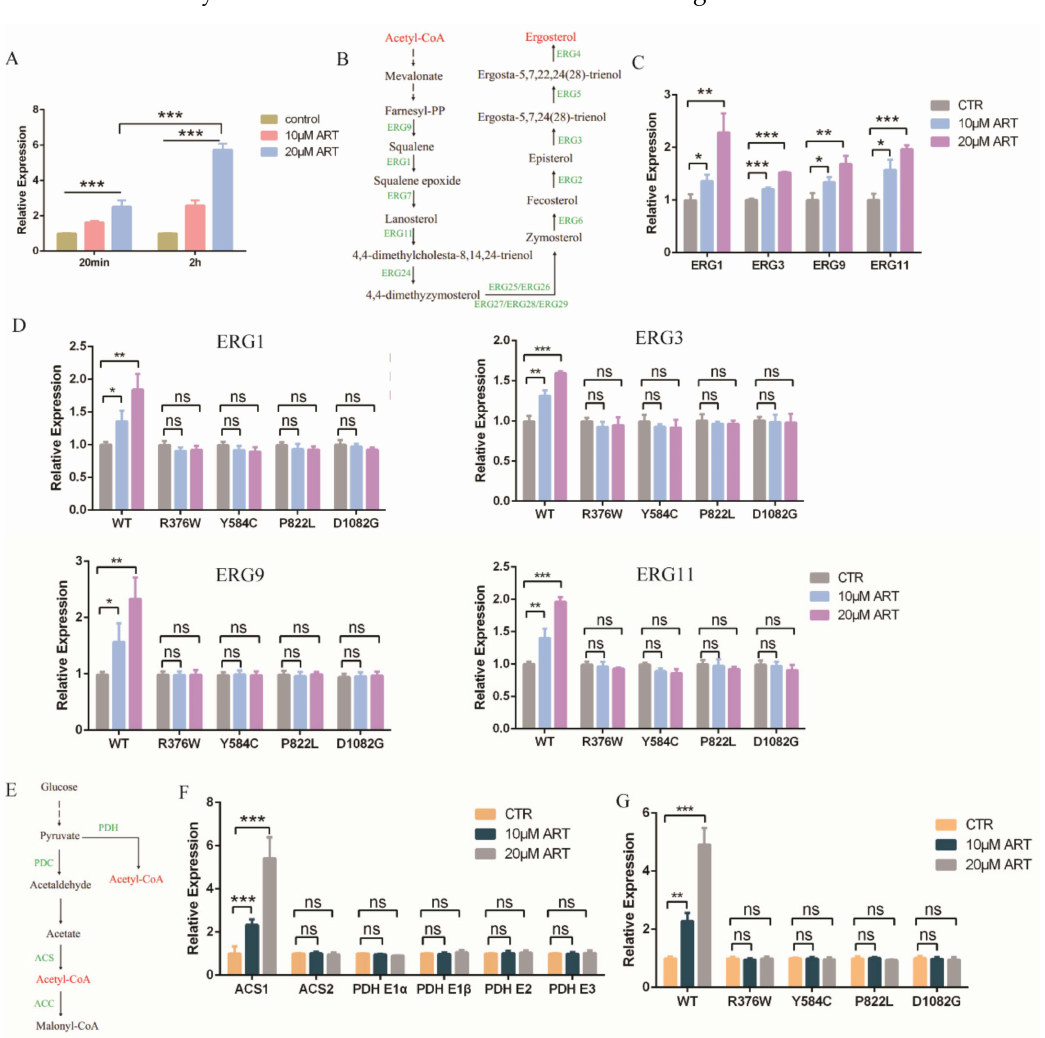
Figure 4. Artemisinin effects on ergosterol and acetyl-CoA synthesis through PDR1. ( A ) Transcription level of Cdr2 with artemisinin. Incubation time were 20 min and 2 h, respectively. Data are mean ± SD of three independent experiments. Data were analyzed by GraphPad Prism. *** p -value < 0.0005. ( B ) Ergosterol synthesis pathway. ( C ) Genes involved in ergosterol synthesis pathway were down- regulated with artemisinin. ( D ) Erg1 , Erg3 , Erg9 and Erg11 transcription levels had no significant change with artemisinin in PDR1 mutants. ( E ) Acetyl-CoA synthesis pathway. ( F ) Acs1 but not Acs2 or Pdh complex was upregulated in the presence of artemisinin. ( G ) Acs1 transcription level had no significant change with artemisinin in PDR1 mutant strains. Data are mean ± SD of three inde- pendent experiments. Data were analyzed by GraphPad Prism. * p -value < 0.05, ** p -value < 0.005, *** p -value < 0.0005, and ns means no significant change ( p -value >